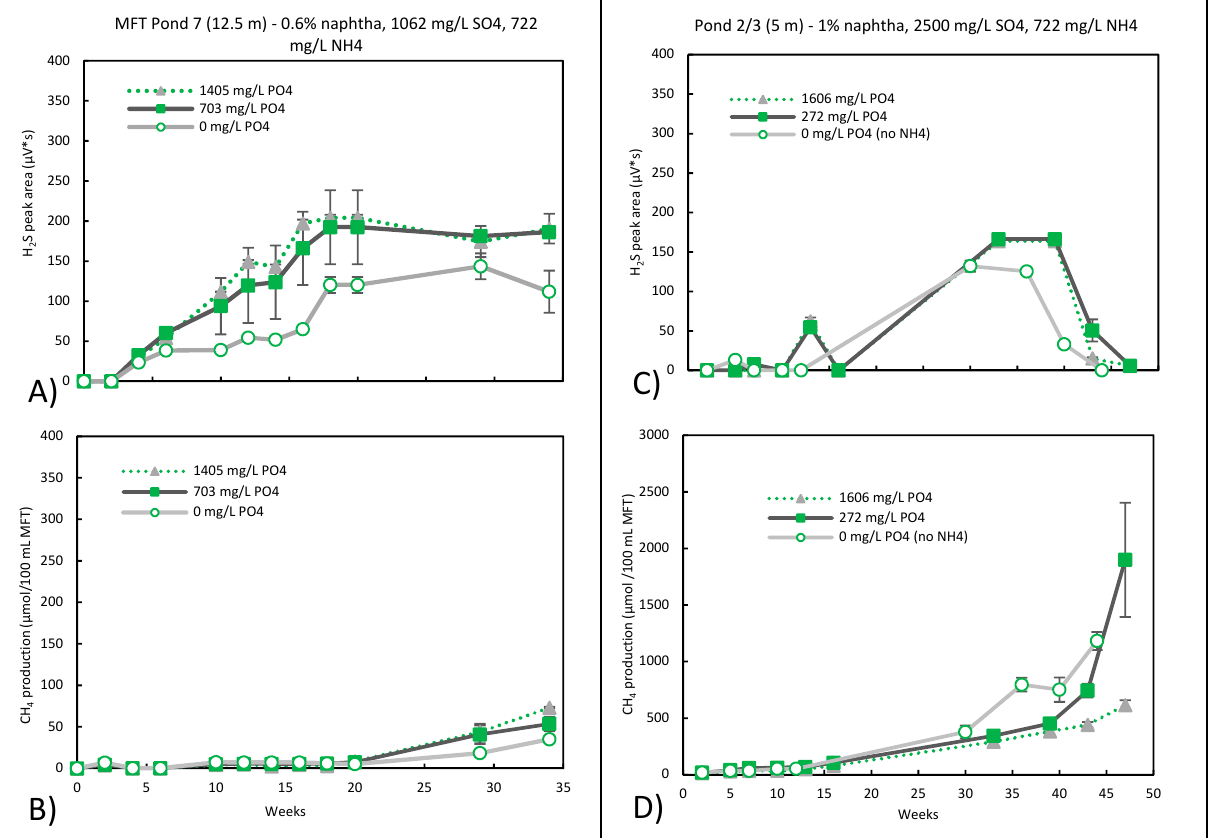
Figure 3. The effect of NH 4+ and PO 43- on ( A ) H 2 S and ( B ) CH 4 production by Pond 7 (12.5 m) MFT and ( C ) H 2 S and ( D ) CH 4 production by Pond 2/3 (5 m) under sulphate-reducing conditions. Measured sulphate concentrations in the pore waters of Pond 7 at week 0 was ~645 mg/L, which decreased to below detectable levels by week 34. For Pond 2/3 (5 m) at week 0, it was ~1400 mg/L, decreasing to ~24 mg/L by week 13, and was below detectable levels by week 44. Microcosms were setup in duplicate, error bars were inserted, and where not visible, the error was too small to be seen.